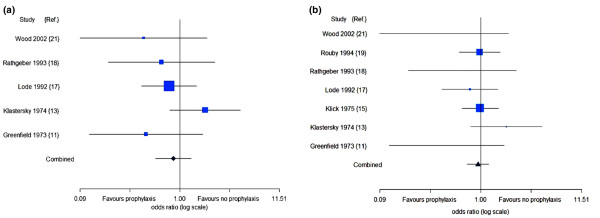
Odds ratios of mortality between patients who received antibiotic prophylaxis via the respiratory tract and those who received placebo or no therapy. (a) Primary analysis (only randomized controlled trials); (b) secondary analysis (including non-randomized trials). Vertical line = 'no difference' point in mortality between the two regimens. Horizontal lines = 95% confidence interval. Square = odds ratio; the size of each square denotes the proportion of information given by each trial. Diamond/triangle = pooled odds ratio for all studies.